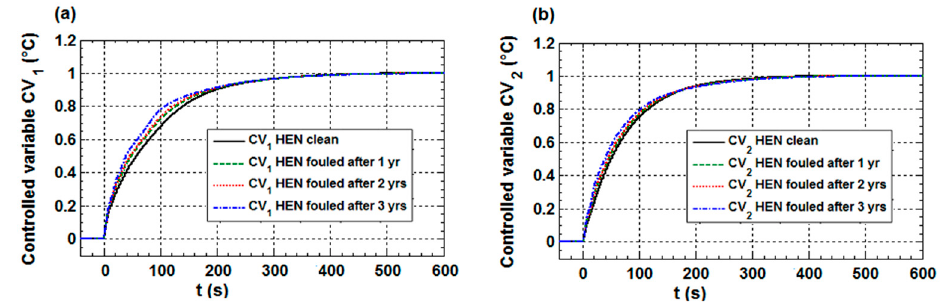
Figure 16. Closed-loop step responses (case no. 1) under fouling conditions of the control variable ( a ) CV 1 and ( b ) CV 2 to setpoints step change. Table 5. Values of the control-quality indices for PID tuned in clean conditions for different periods of operation (case no. 1).